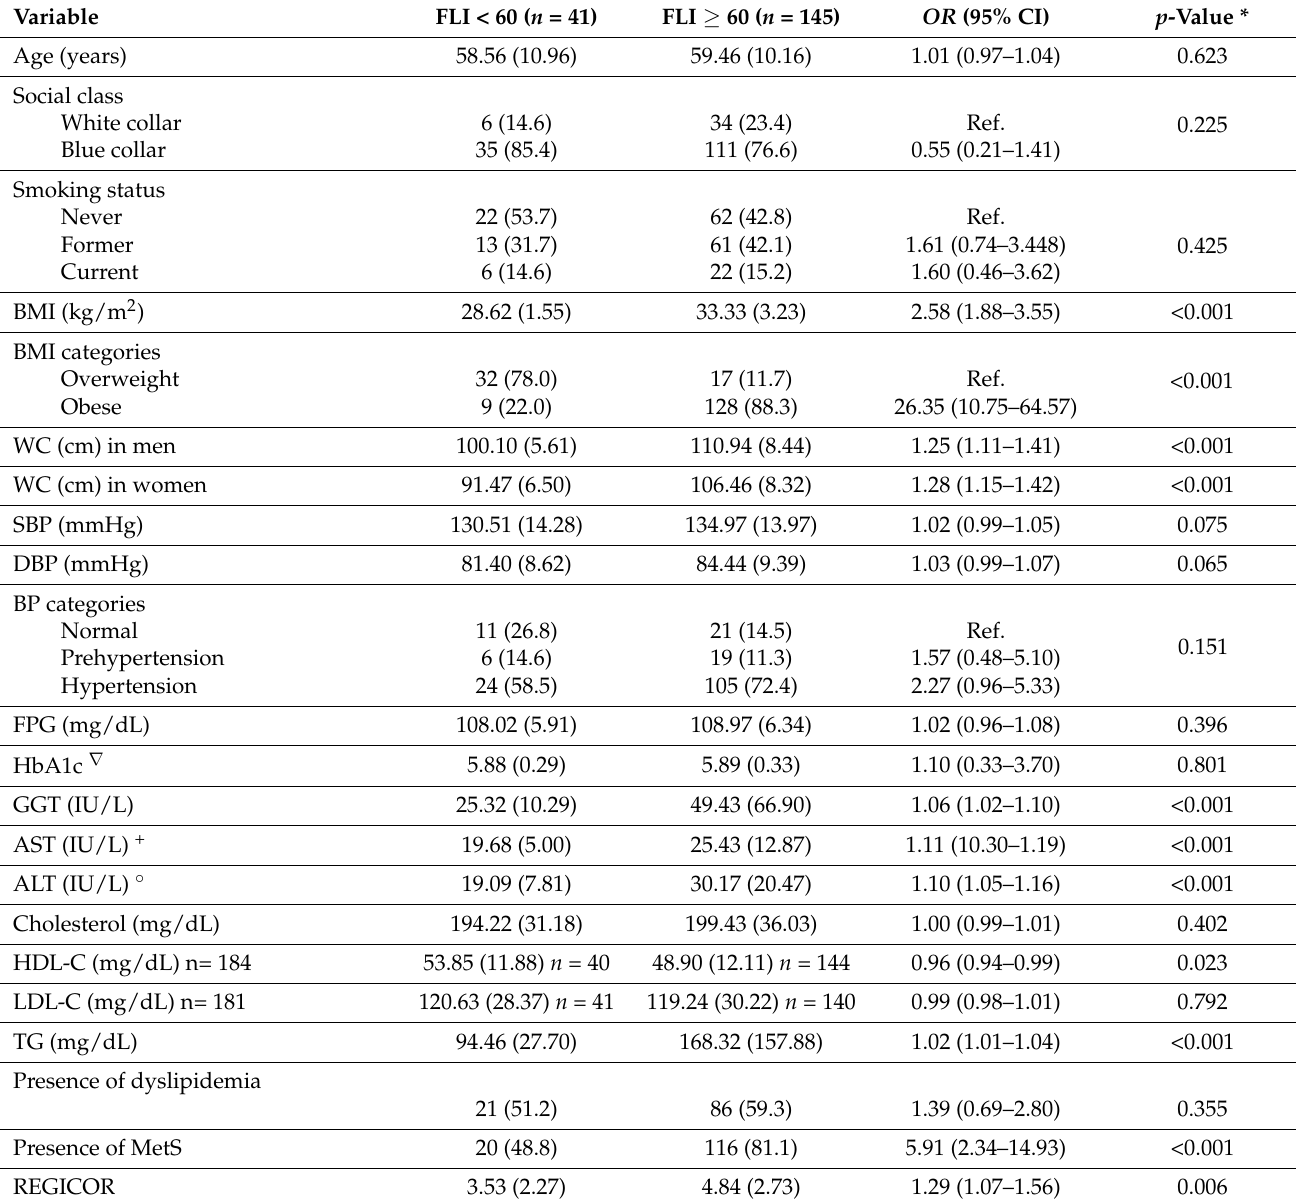
Table 2. Anthropometric characteristics and biochemical parameters of the study population by FLI